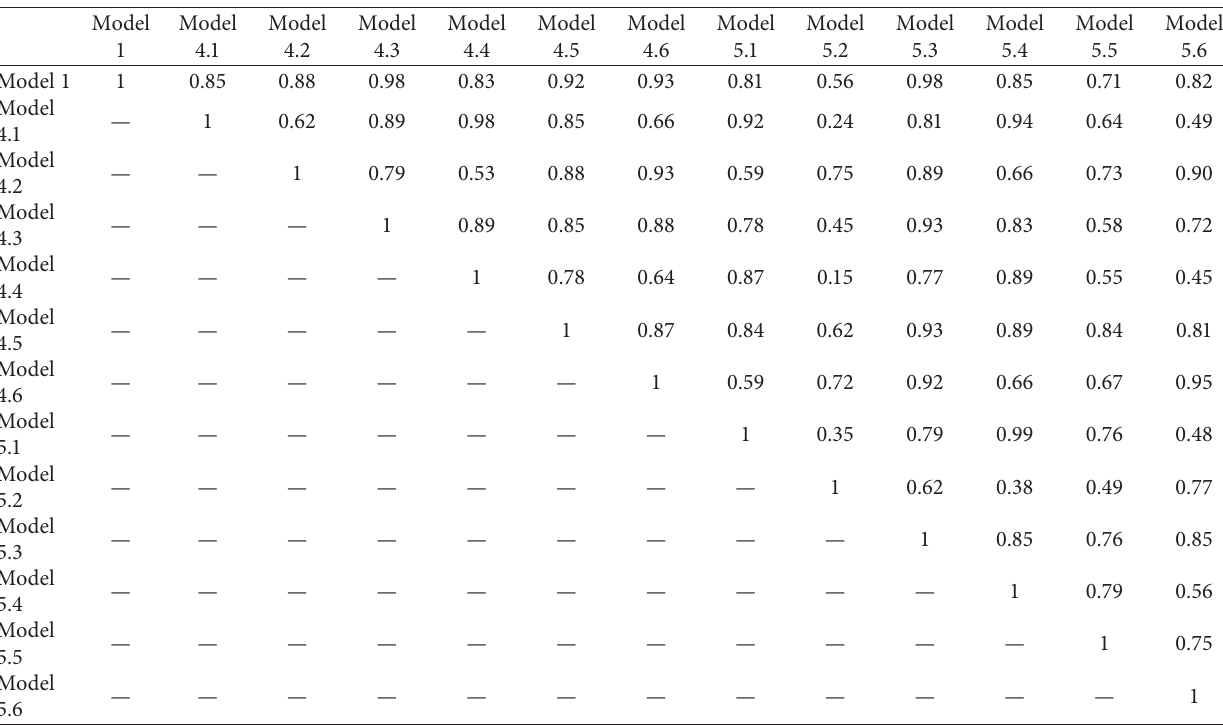
Table 21: Correlation of the ranks in the models 1, 4, and